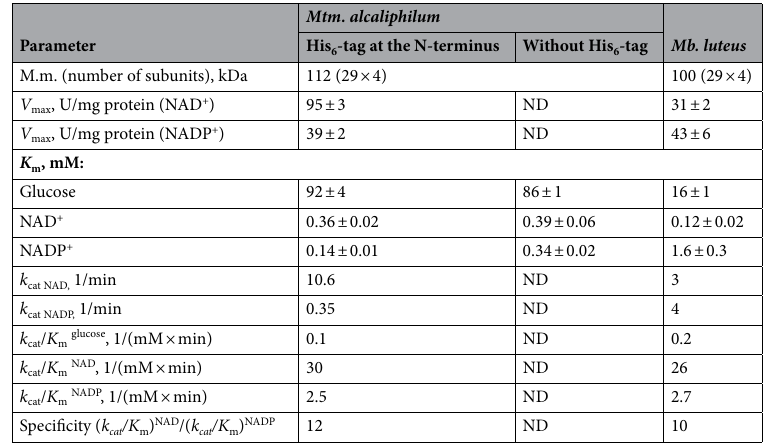
Table 1. The kinetic properties of GDHs from methanotrophs. ND not determined.